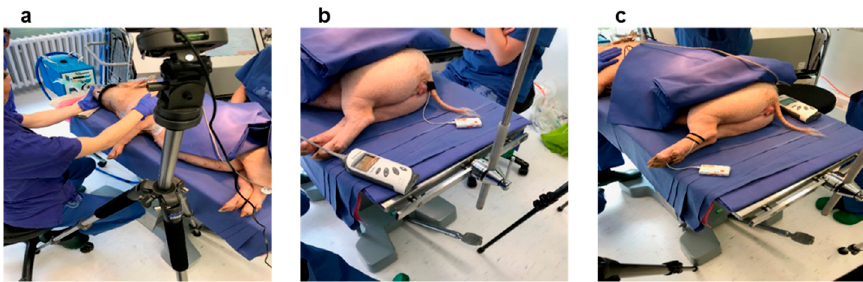
Figure 1. The test pig under anaesthetisation with PPG sensor placed on the left ear ( a ), on the tail ( b ) and on the left back leg( c ).